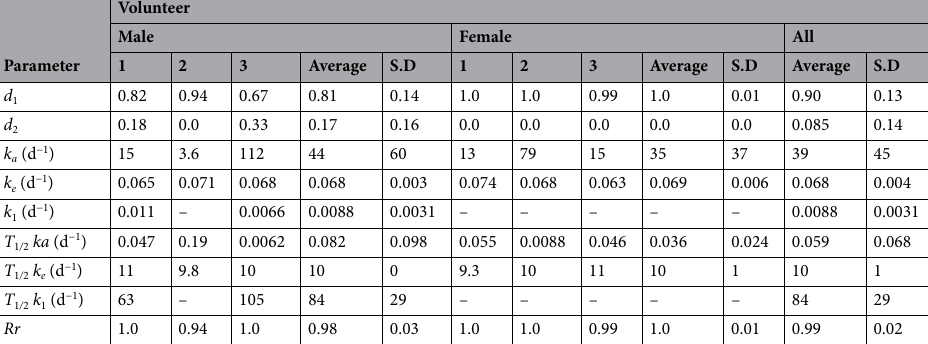
Table 3. Estimated parameters of OBD model for each volunteer administered with D-labelled alanine. S.D., standard deviation;